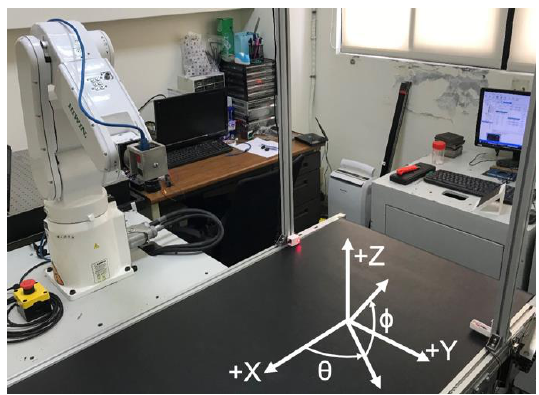
q q and the tilting angle f of the normal vector ¢ n and the tilting angle f of the normal vector ¢ n